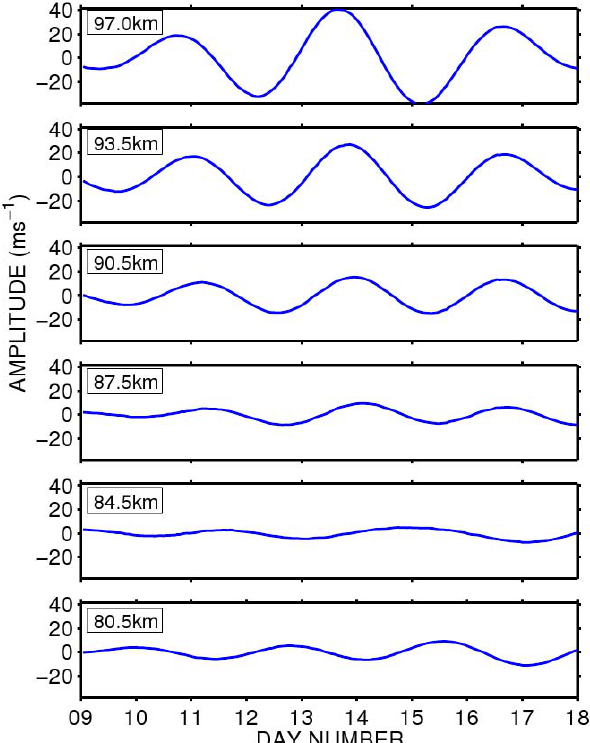
Fig. 4. Zonal winds over Ascension Island for the period 9–18 Jan- uary 2006 bandpassed between 2.5–4.5 days for six heights (height labels represent the centre of each